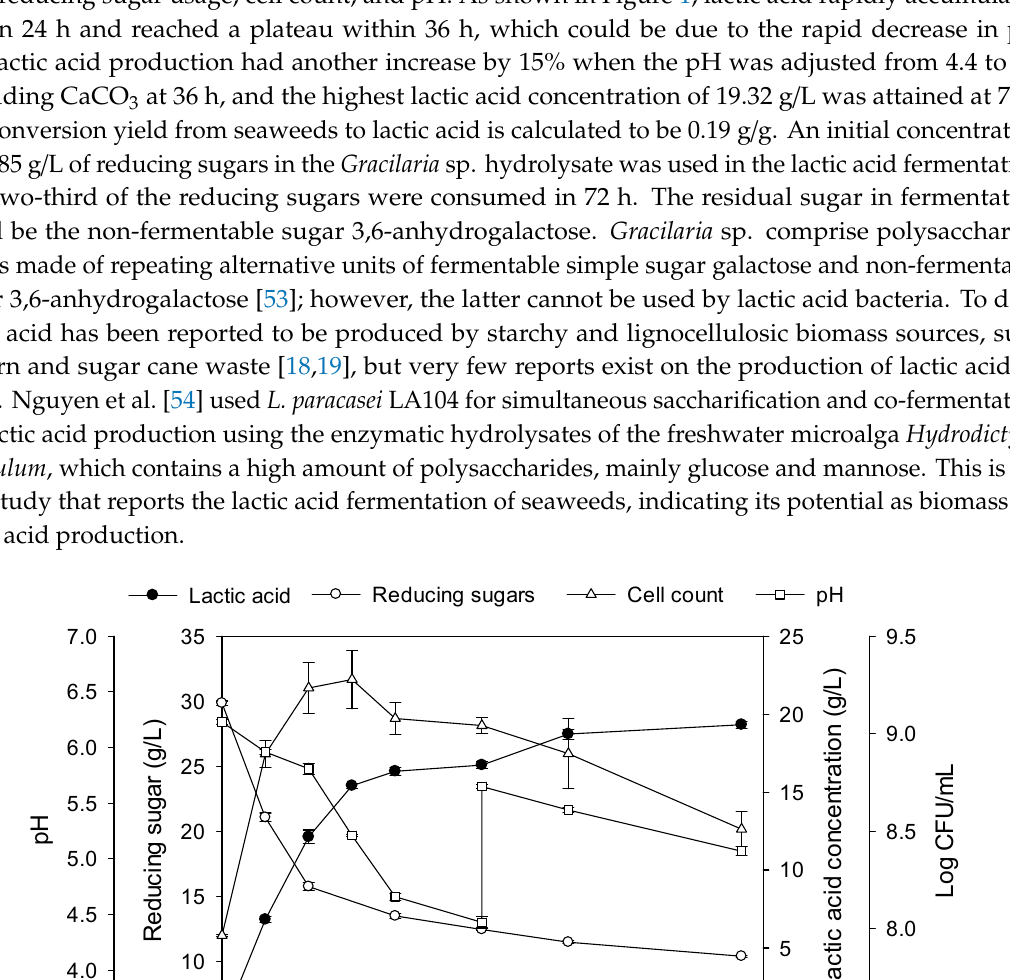
Table 6. The effects of temperature on lactic acid fermentation.